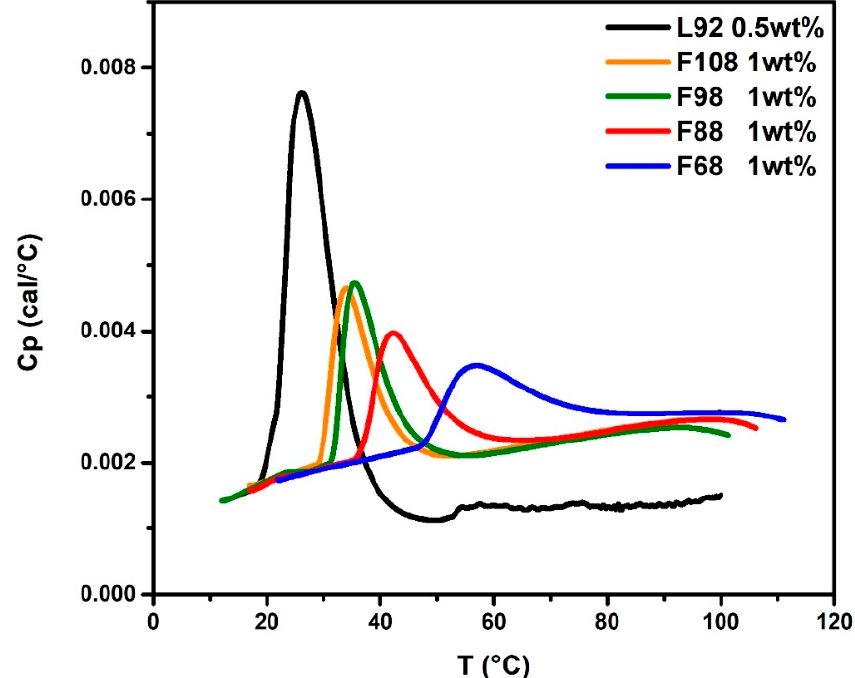
Figure 2. The HSDSC thermograms of pure Pluronic solutions.